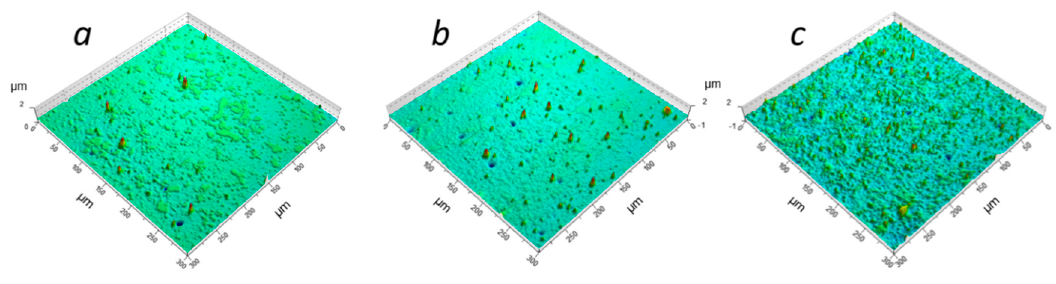
Figure 8. Three-dimensional (3D)-profilometry image of TiN coatings deposited on D2 tool steel substrate evaporation using thermionic arc ( a ), magnetron sputtering ( b ), and cathodic arc ( c ). The sharp peaks are the nodular defects while the blue dots are craters (pay attention to the strong exaggeration in z-scale).